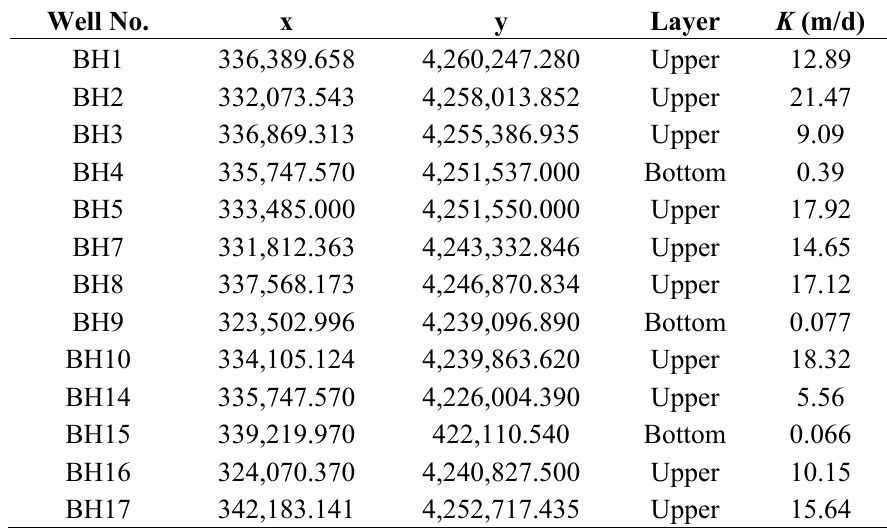
Table 1. The hydraulic conductivity measurements in the study area.